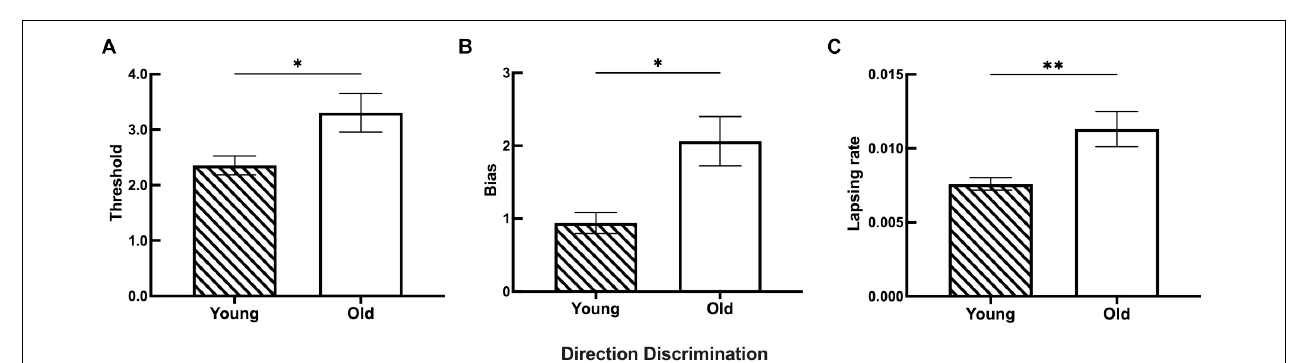
FIGURE 7 | The discrimination ability difference of motion direction between the young and old groups. (A) Statistical results showing the threshold differences between the young ( n = 26) and old ( n = 27) groups. (B) Statistical results showing the bias differences between the young ( n = 23) and old ( n = 26) groups. (C) Statistical results showing the lapsing rate differences between the young ( n = 27) and old ( n = 24) groups. Data are expressed as mean ± SEM. * p < 0.05 for the young group and the old group in the threshold and bias analyses. ** p < 0.01 for the young group and the old group in the lapsing rate